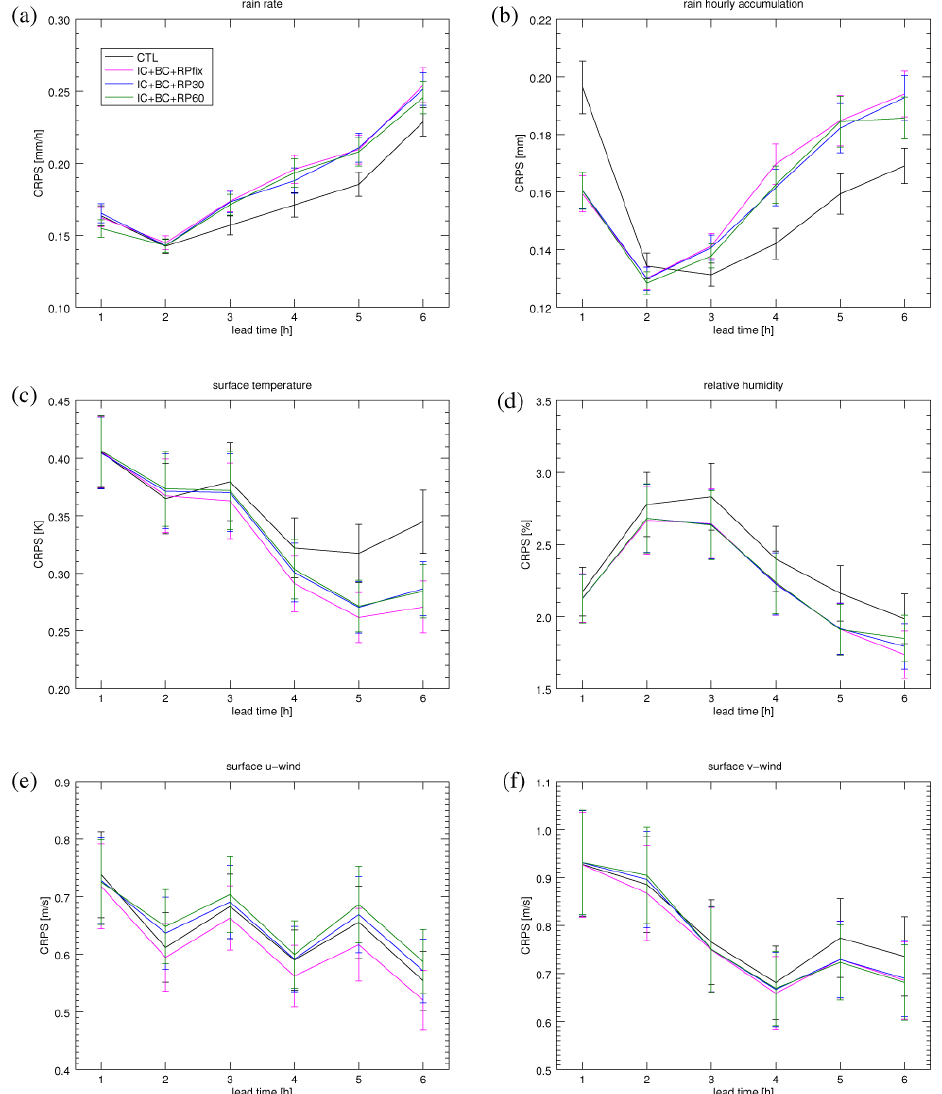
Fig. 17. CRPS for (a) rain rate, (b) hourly rain accumulation, (c) 1.5m temperature, (d) 1.5mRH, (e) u component of 10m wind and (f) v component of 10m wind. The CRPS shown is the mean CRPS over the domain for each ensemble; error bars show the standard error in the mean. The observation error standard deviations used in the calculation are (a) σ o = 0 . 47mmh − 1 , (b) σ o = 0 . 47mm, (c) σ o = 0 . 69K, (d) σ o = 4 . 72 %, (e) σ o = 1 . 54m s − 1 and (f) σ o = 1 . 54m s − 1 . These values were estimated from spread-skill plots for this